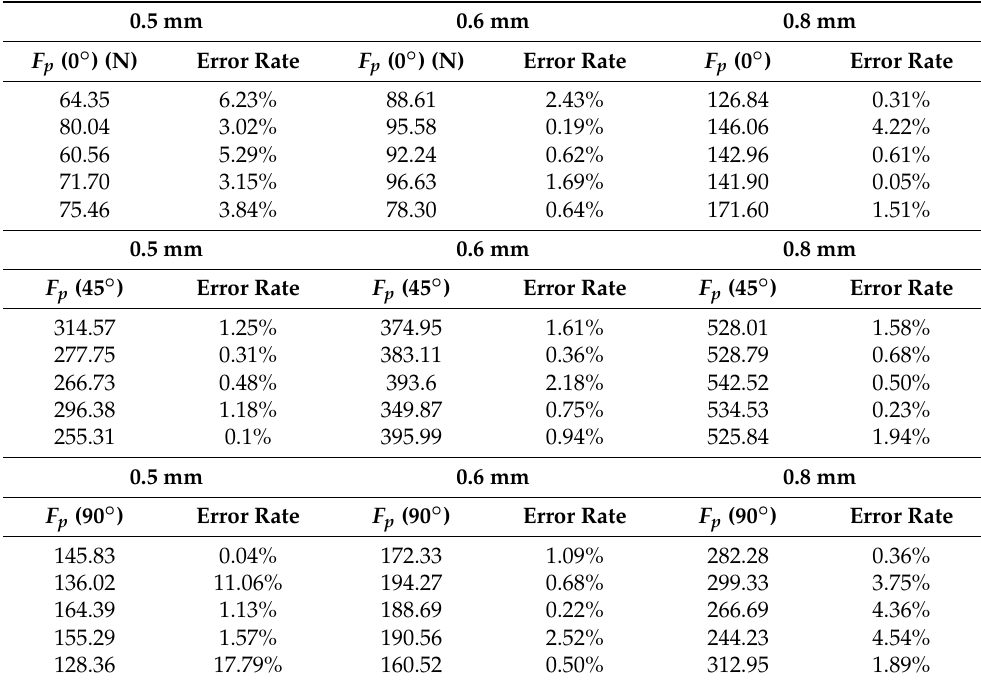
Table 6. The error rate of the predicted value under different